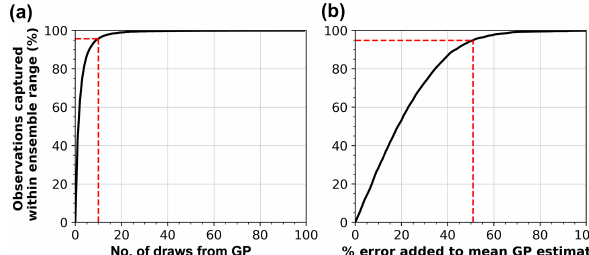
Figure 5. (a) Percent of observed runup values captured within the range of ensemble predictions made by randomly sampling dif- ferent runup values from the Gaussian process. Only 10 randomly drawn models can form an ensemble that captures 95% of the scat- ter in observed R 2 values. (b) An experiment showing how much arbitrary error would need to be added to the mean GP runup pre- diction in order to capture scatter in R 2 observations. The mean GP prediction would have to vary by 51% in order to capture 95% of scatter in R 2